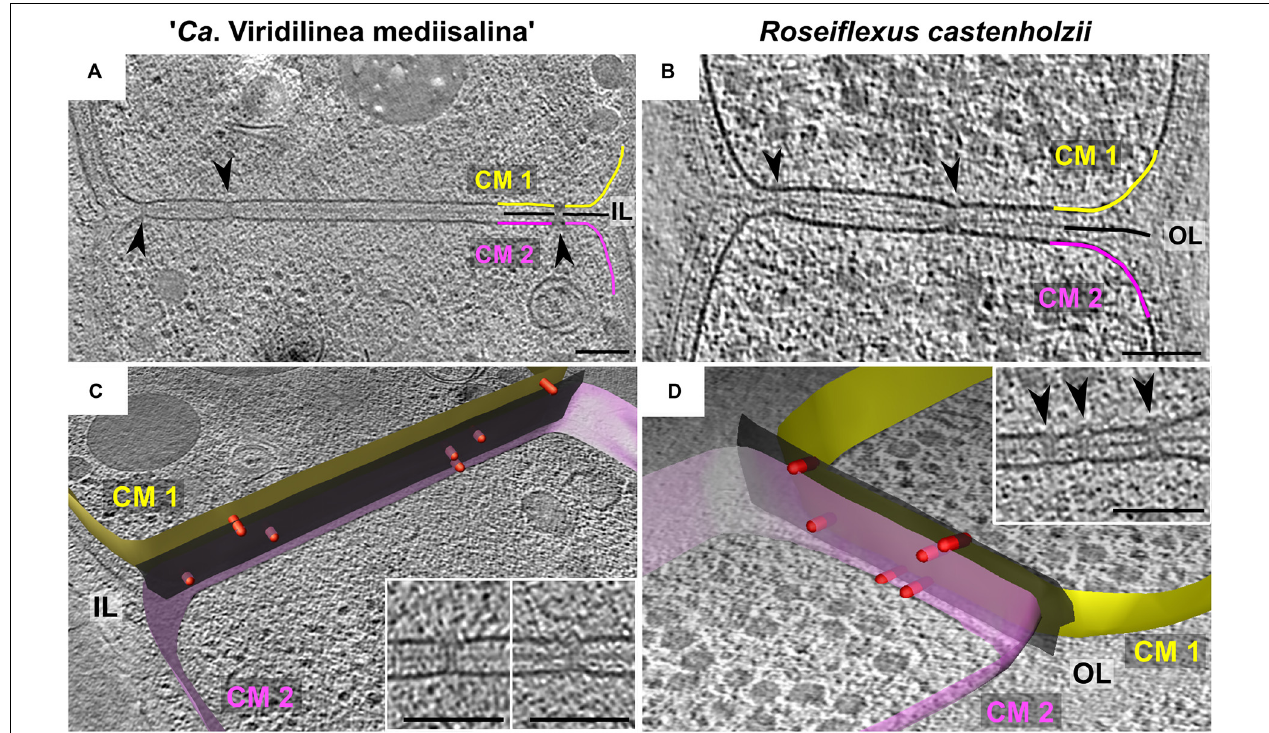
FIGURE 2 | Slices through tomograms of septa between two “ Ca . Viridilinea mediisalina” cells (A) and two R. castenholzii cells (B) . Segmentation of cell envelope and septal channels from tomograms of “ Ca . Viridilinea mediisalina” (C) and R. castenholzii (D) : yellow (CM1) and pink surface (CM2) – cytoplasmic membranes of the two neighboring cells, black surface (Ol and IL) – outer and intermediate layer, red rods – the septal channels. Insertions in (C,D) show representative view of the septal channels. Arrows point the septal junctions. (B,D) show different tomograms of R. castenholzii . Bars: 100 nm.